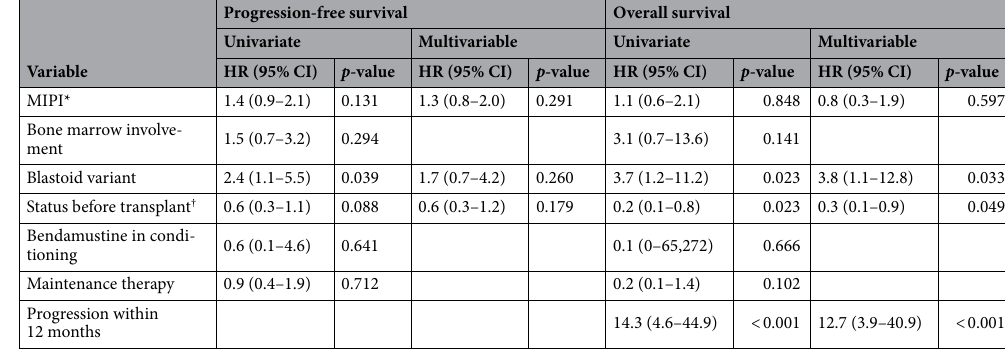
Table 3. Univariate and multivariable analyses for OS of the 94 MCL patients receiving autologous stem cell transplant. P values < .05 are considered statistically significant. Only variables with P value less than 0.10 in univariate analysis were incorporated into the multivariable Cox proportional hazard regression analysis. CI confidence interval, HR hazard ratios, MIPI mantle cell lymphoma international prognostic index. *MIPI: stratified into low-, intermediate-, and high-risk groups. † Transplant at first complete remission versus